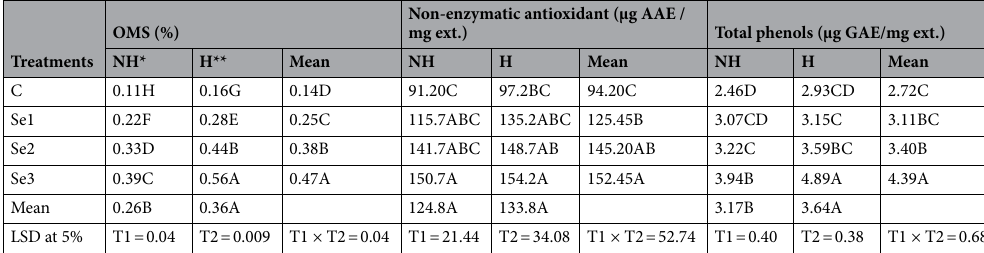
Table 6. Effect of selenium and K-humate application on organic matter in soil (OMS), non-enzymatic antioxidant, and total phenols in oats. *Refers to Se application without K-humate. **Refers to the simultaneous application of Se and K-humate.